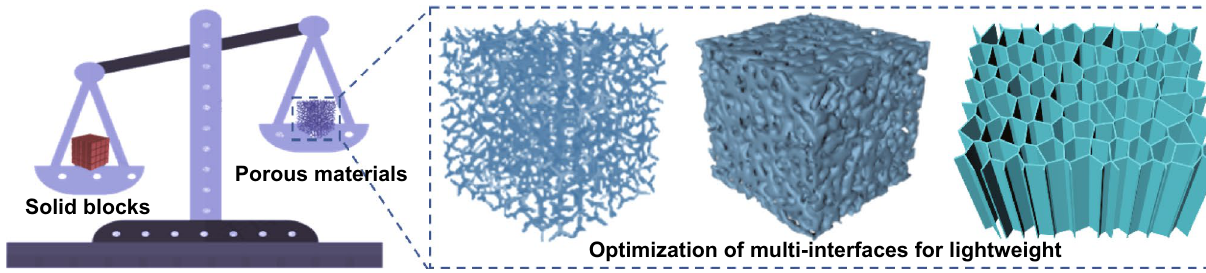
Fig. 2 Schematic diagram of optimization of multi-interfaces for